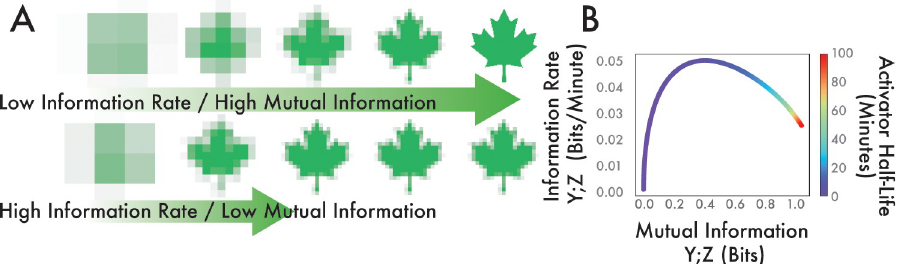
Fig 4. Trade-offs in mutual information versus information rate as a function of activator half-life. (A) Illustration of the differences between information rate and maximum information. Growing resolution of maple leaf indicates increased information. Top row has higher maximum information, but it is accrued at a lower rate as compared to the bottom row. (B) Mutual information and information rate between two downstream genes as a function of activator